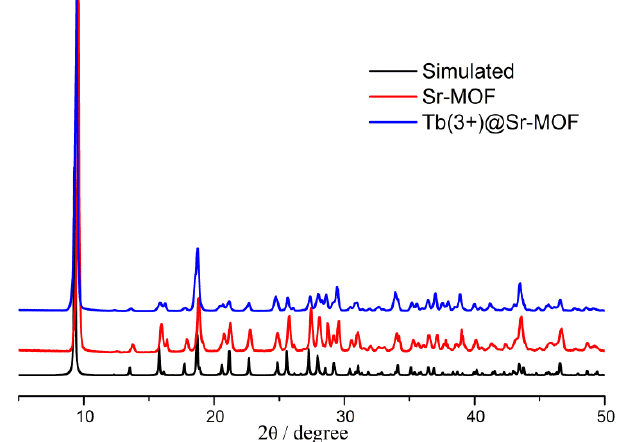
Figure 2. PXRD patterns of the simulated Sr-MOF, Tb(3+)@Sr-MOF.